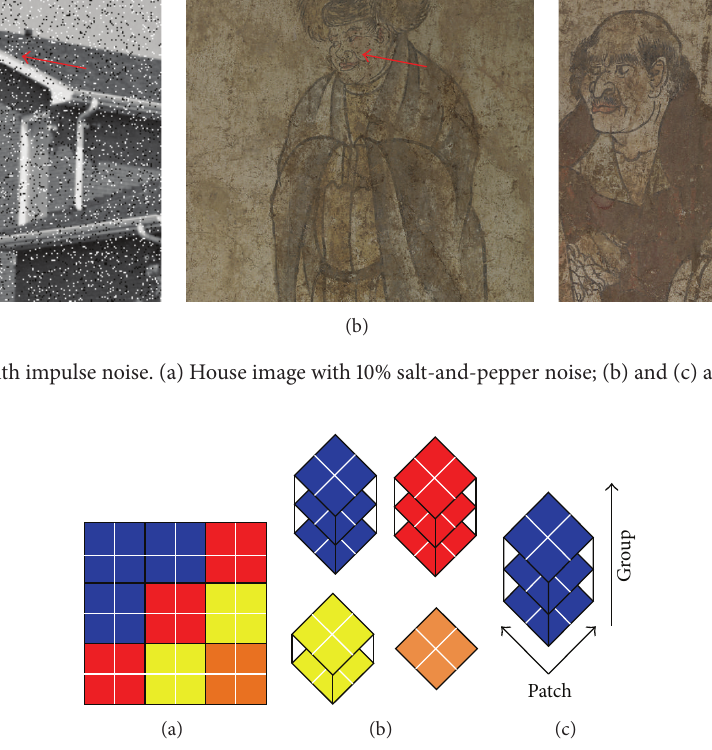
Figure 2: Group image patches. (a) An image; (b) four groups of similar patches; (c) the patch and group dimension.